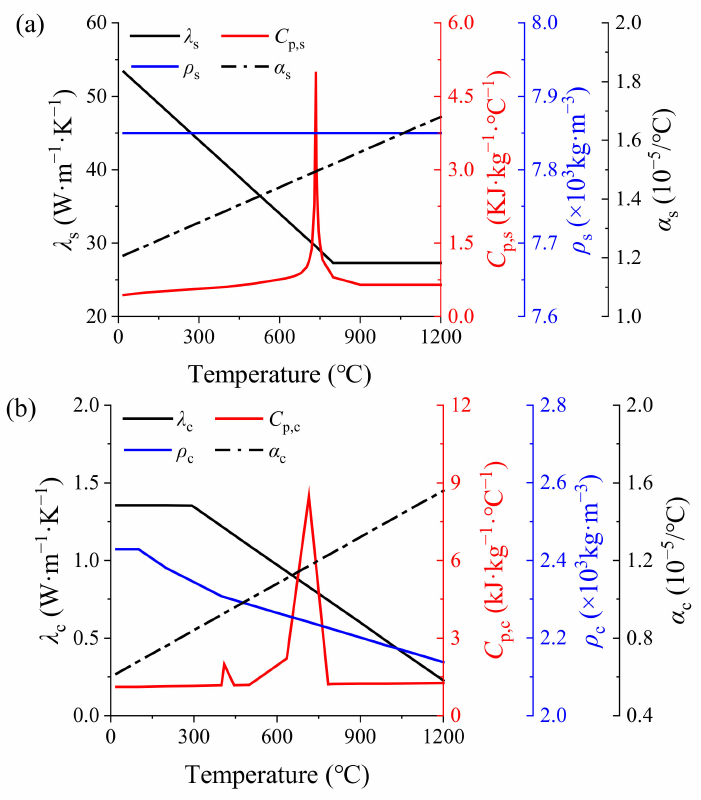
Figure 3. Thermophysical parameters of ( a ) reinforcement steel and ( b )